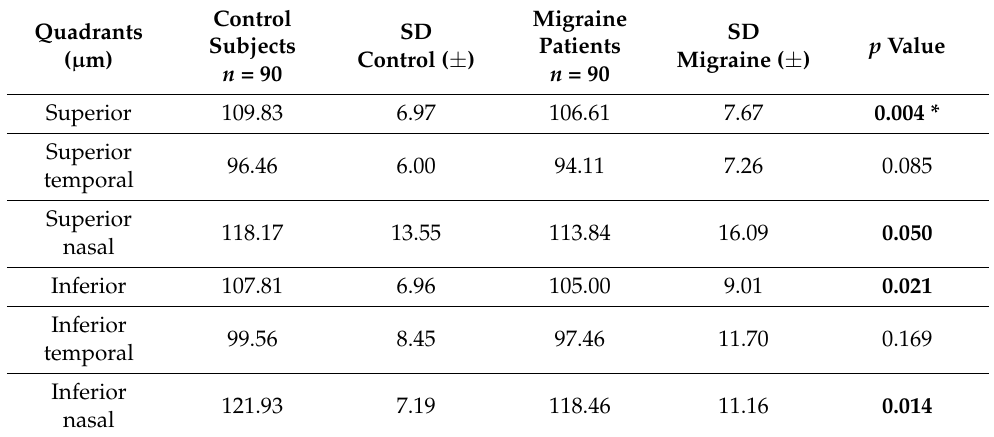
Table 8. GCL++ thickness ( µ m) in each of the 90 ◦ quadrants around the macula. Quadrants ( µ m)